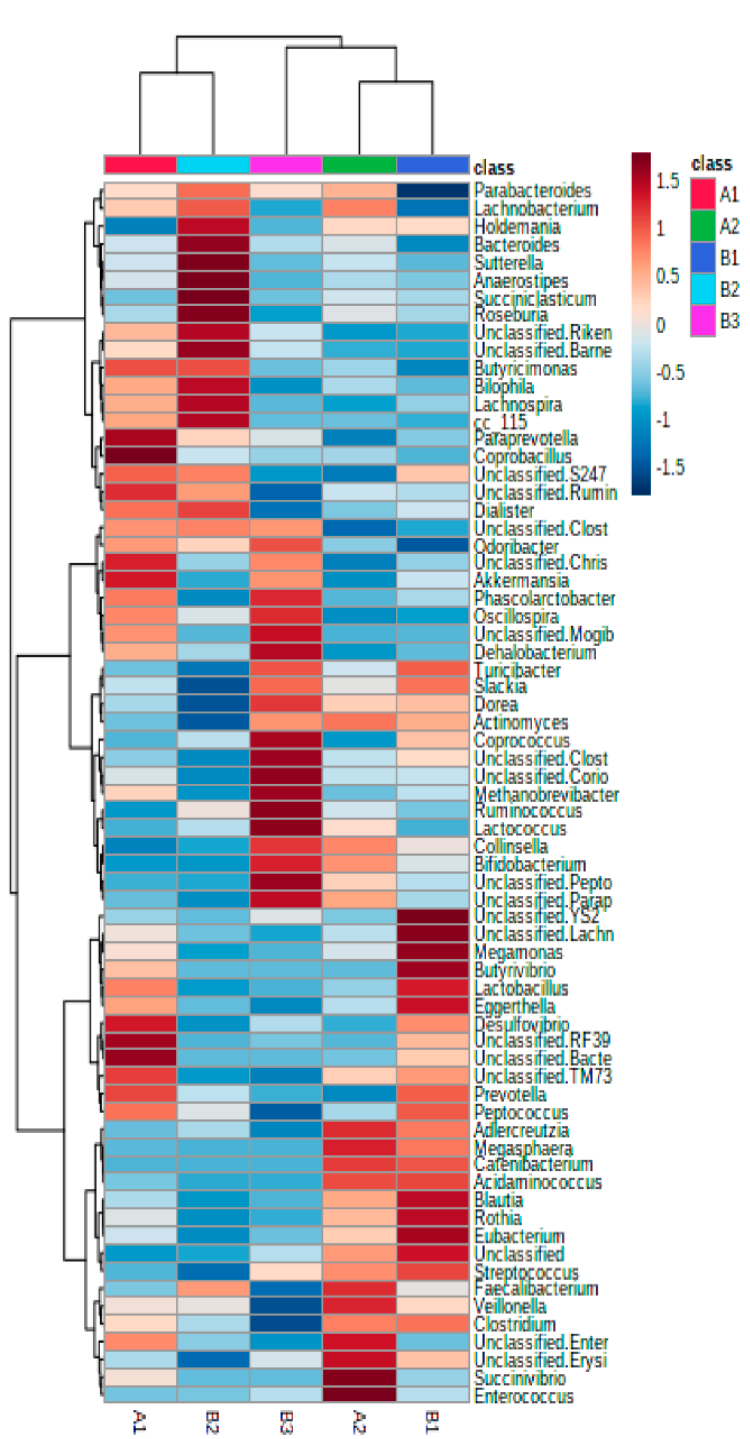
Figure 2. Hierarchical clustering heatmap showing the strongest contributors (Euclidean distance and Ward clustering algorithm).